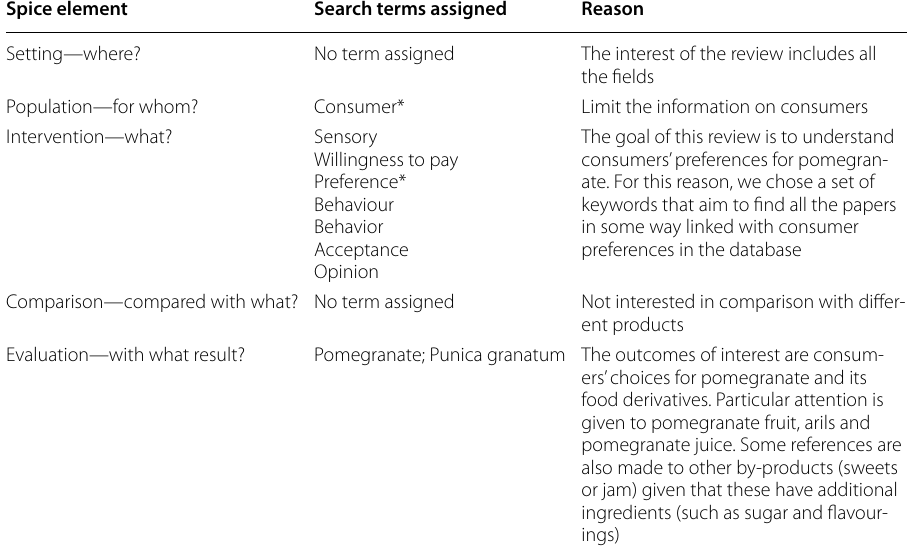
Table 1 Application of the SPICE framework in defining the research objective Spice element Search terms assigned Reason Setting—where? Population—for